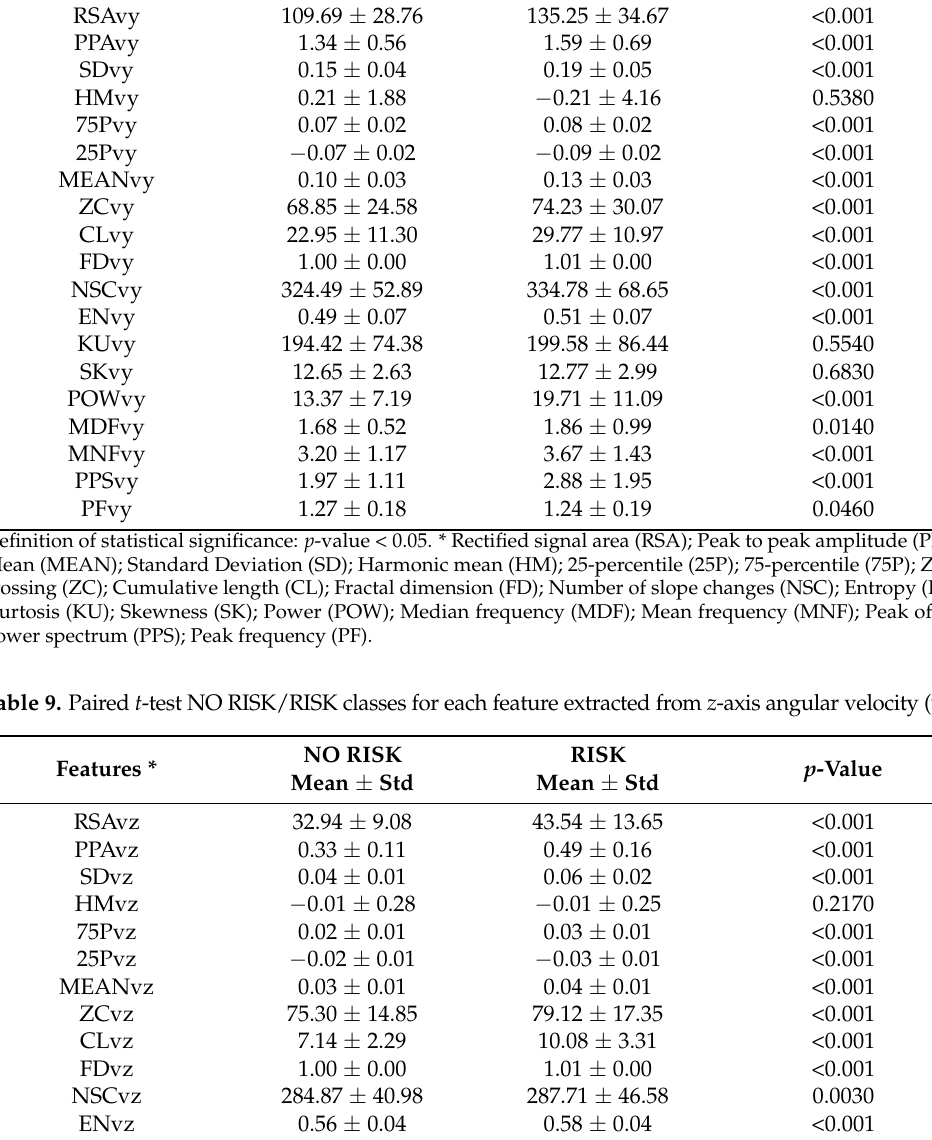
Table 8. Paired t -test NO RISK/RISK classes for each feature extracted from y -axis angular velocity (vy). Features *